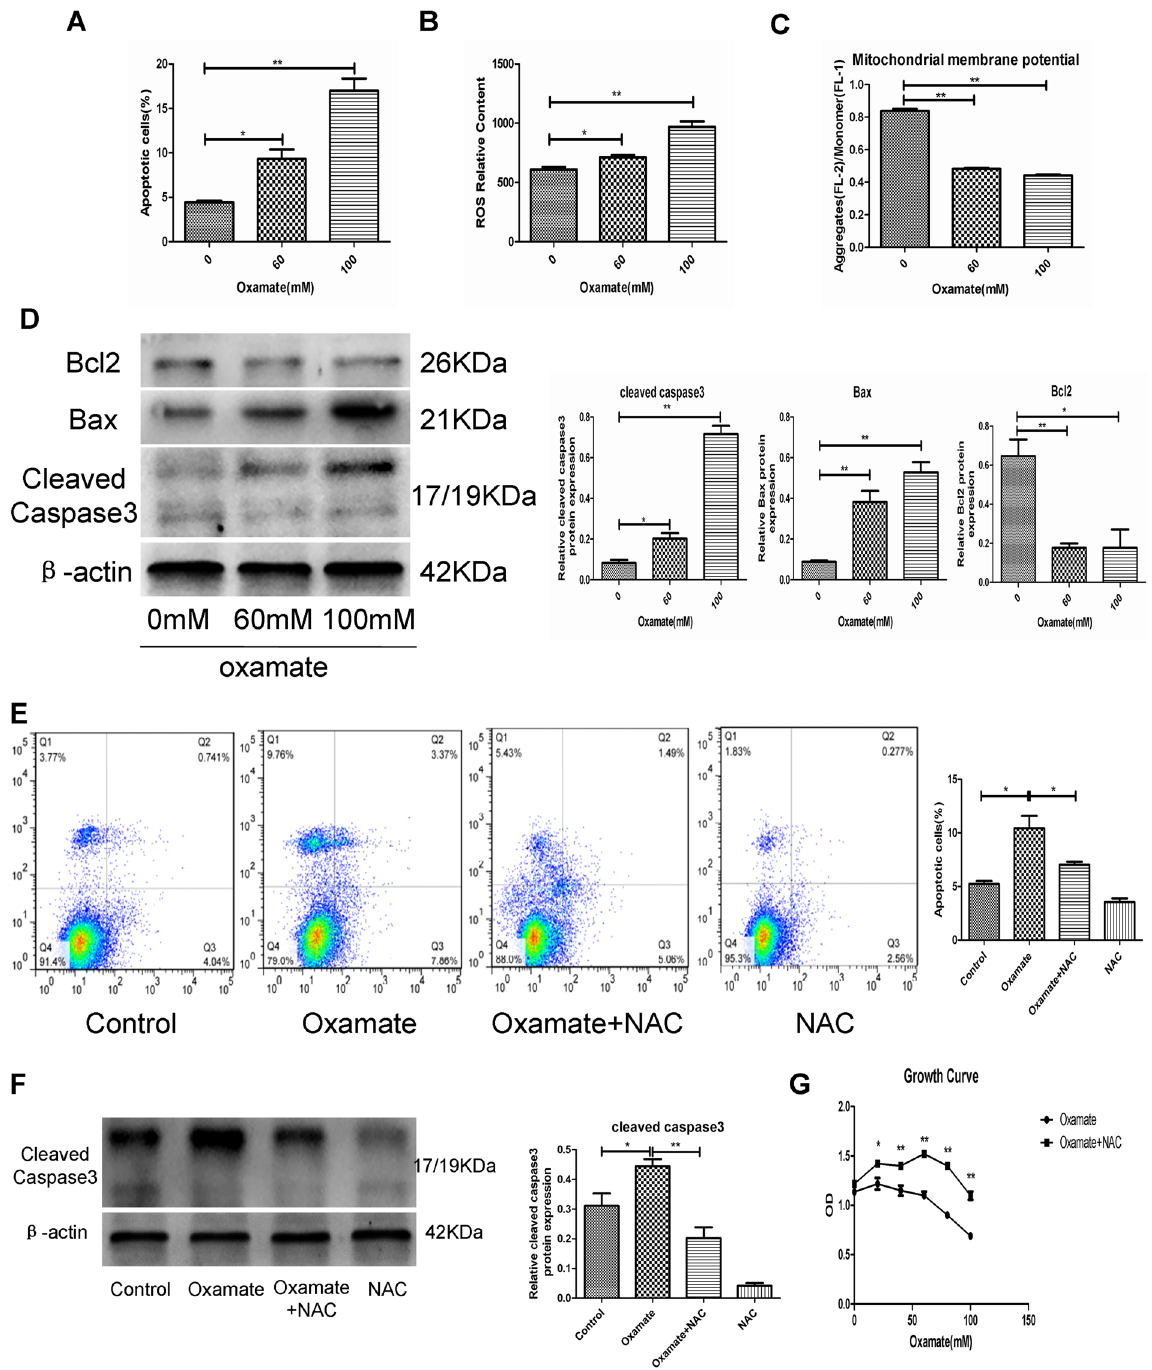
Figure 6. ROS triggered mitochondrial apoptosis pathway of GH3 cells after treatment with oxamate. ( A ) GH3 cells were exposed to 0, 60, and 100 mM oxamate for 48 h and cell apoptosis were measured by flow cytometry (n = 3, ± SEM). ( B ) Intracellular ROS levels of different treatment groups were determined by DCFH-DA fluorescence (n = 3, ± SEM). ( C ) Mitochondrial membrane potential were measured in different treatment groups by JC-1 staining (n = 3, ± SEM). ( D ) Protein expression levels of Bcl2, Bax and Cleaved caspase3 were examined by Western blot (n = 3, ± SEM). ( E and F ) GH3 cells were pretreated with or without NAC and then treated with oxamate. Apoptosis were measured by flow cytometry and cleaved-caspase3 were examined by Western blot (n = 3, ± SEM). ( G ) GH3 cells were incubated with different concentrations of oxamate combined with 10 mM NAC or without for 48 h, and cell proliferation were tested by CCK-8 assay (n = 6, ± SEM). * P < 0.05; ** P <